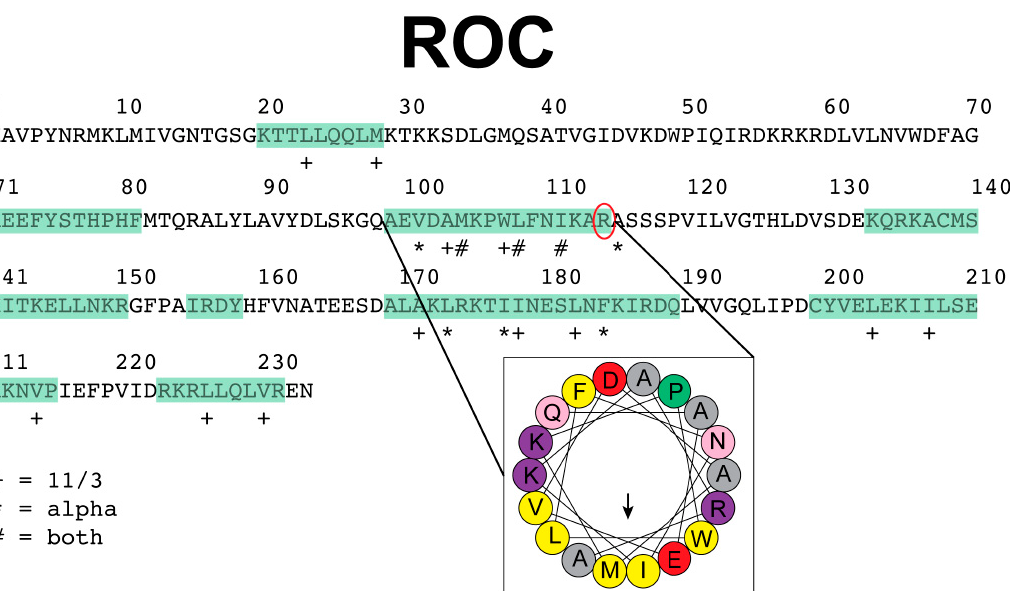
Figure 3. Candidate AKAP-like helix in the LRRK2 ROC domain. The sequence of the ROC domain is presented with alpha helices identified from sequence analysis highlighted in green. A candidate amphipathic helix was identified within the ROC domain of LRRK2 and is highlighted by the black lines leading to the inset image of the helical wheel. This helix contains the clinically relevant residue R1441 (circled in red). In the legend the “+” indicates resides belonging to a hydrophobic face when a 3–11 helix is generated. The “*” indicates residues belonging to the hydrophobic face when an alpha helix is modeled. The “#” identifies residues that belong to the hydrophobic face when either a 3–11 or alpha helix is generated.